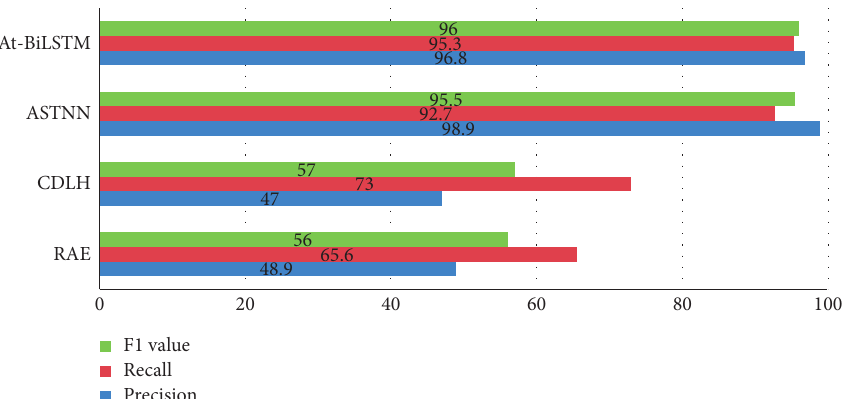
Figure 6: Code clone detection models on OJClone.